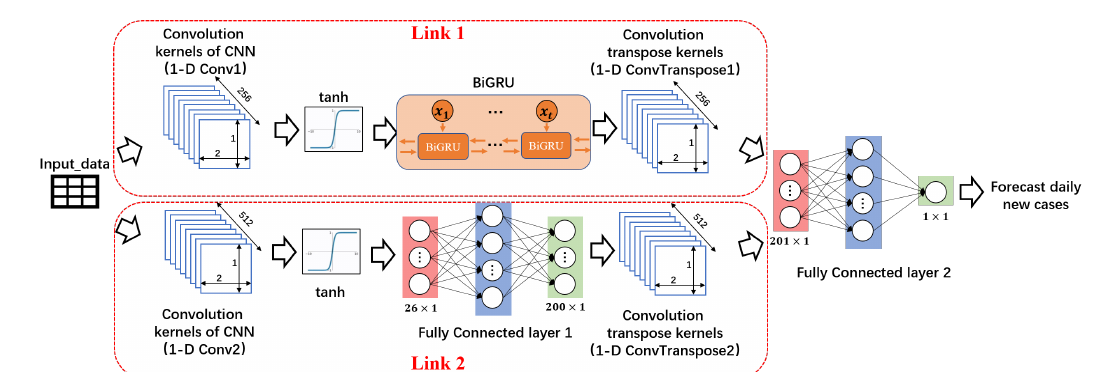
Figure 1. The network structure diagram of Dual-link BiGRU.